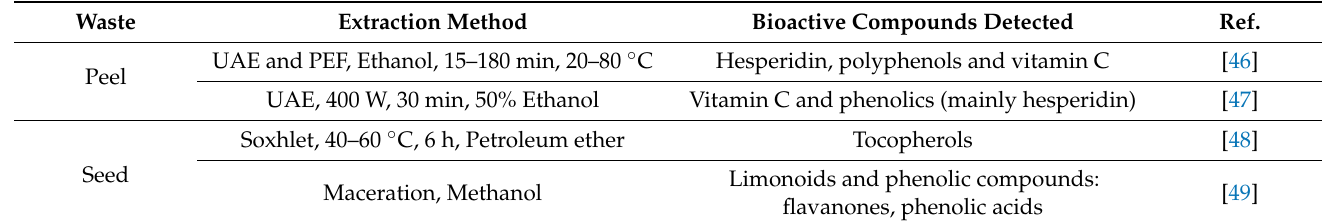
Table 4. Summary of different studies that have been conducted for the extraction of bioactive compounds from wastes of orange ( Citrus sinensis